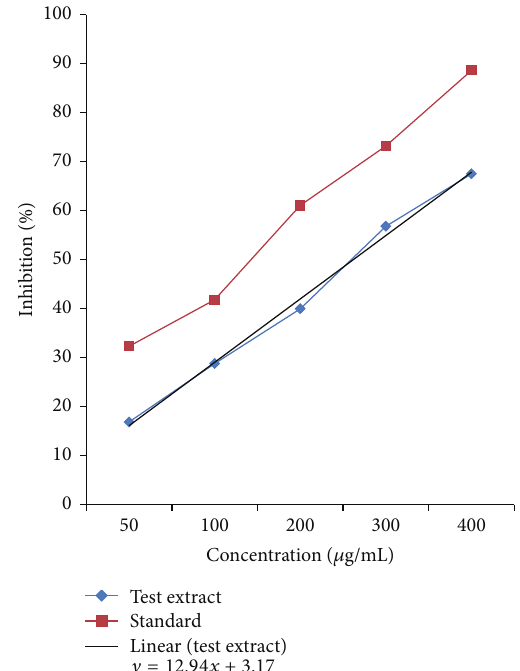
Figure 1: H 2 O 2 radical scavenging assay for hydro-alcoholic extract of Desmostachya bipinnata.